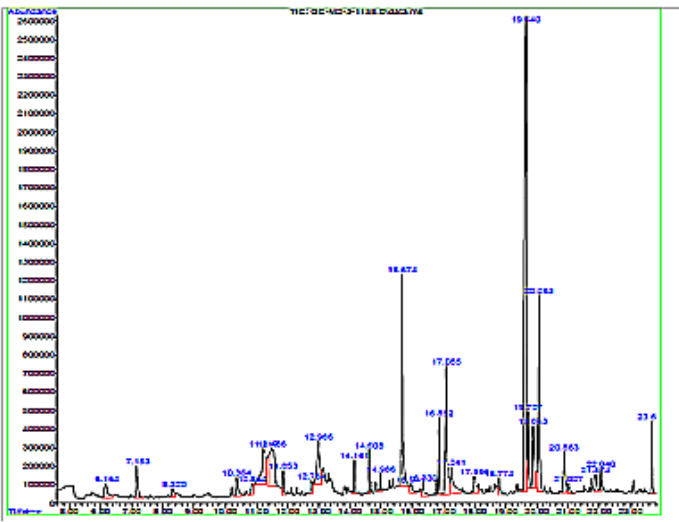
Figure 1. GC-MS spectra of M. oleifera extract.